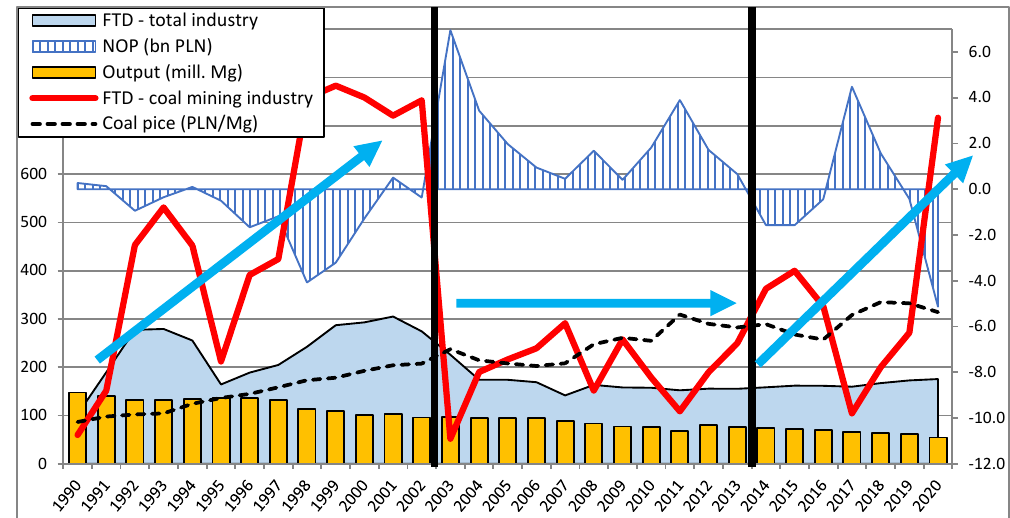
Figure 12. Financial threat degree of going concern (FTD) against key economic criteria for coal mining enterprises in 1990–2020. Note: net operating profit (NOP)—right axis. Source: as in Figure